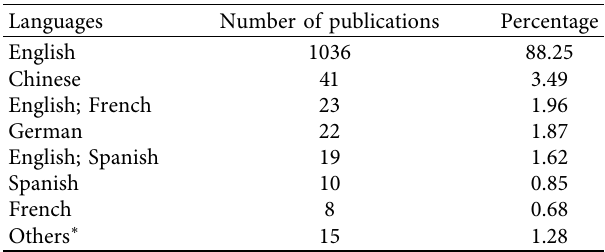
Table 2: The distribution of publications by their type of publication.